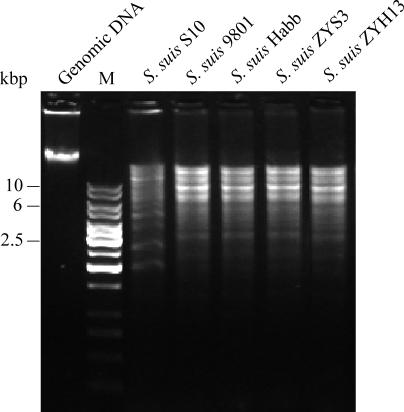
RFLP Analysis of Different
S. suis 2 Isolates

S. suis S10: a highly virulent strain from China;
S.
suis 9801: swine isolate from Jiangsu Province in 1998;
S. suis Habb: human isolate from Jiangsu Province in 1998;
S. suis ZYS3: swine isolate from Sichuan Province in 2005;
S. suis ZYH13: human isolate from Sichuan Province in 2005; M: 1 kb DNA Ladder (MBI Ferments, Gdansk, Poland).